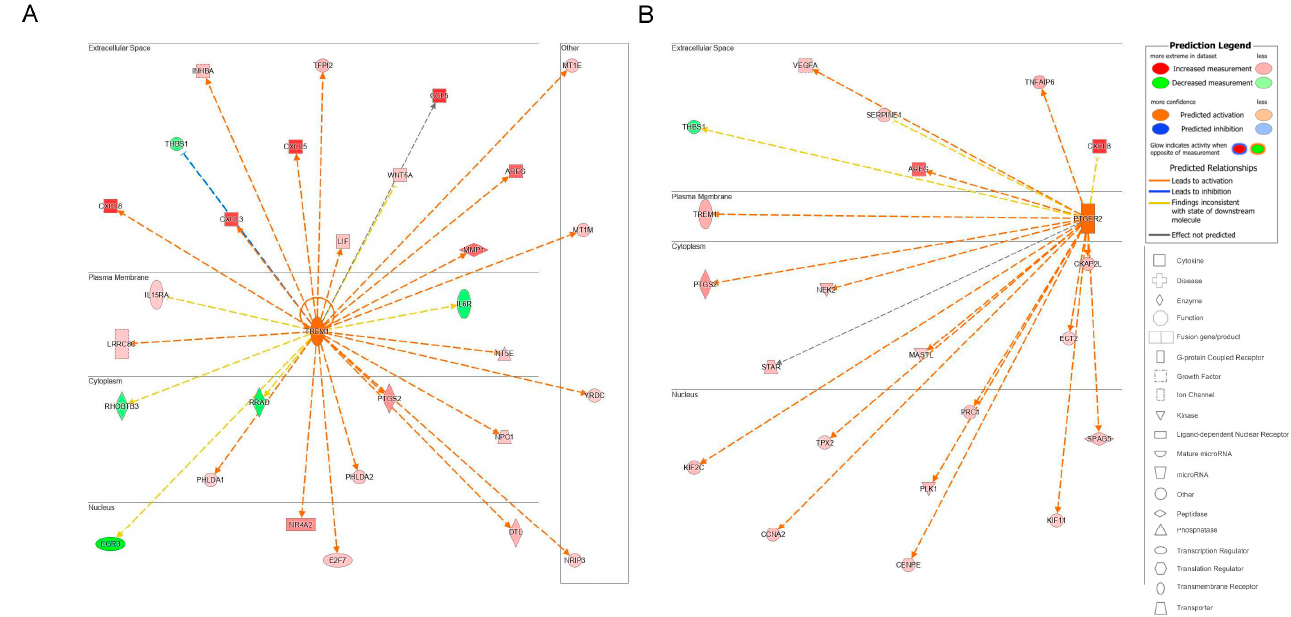
Figure 9. Upstream regulators identified in IPA. The subcellular location of associated target molecules of the upstream regulators ( A ) TREM1, a transmembrane receptor ( p = 1.26 × 10 − 6 ) and for ( B ) PTGER2, a G-protein-coupled receptor ( p = 6.05 × 10 − 8 ) are shown. The differential expression of associated downstream target molecules identified in our dataset is shown (red is increased, green is decreased) as is their subcellular location.